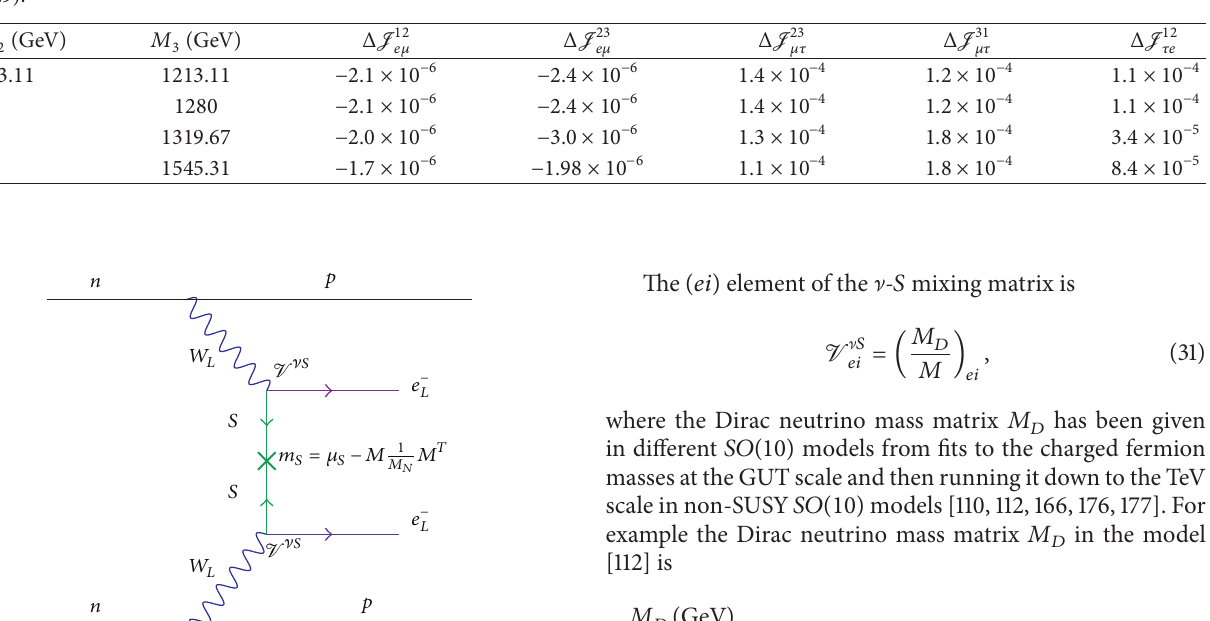
as a result of weak leptonic CP-violation and nonunitarity effects defined CP